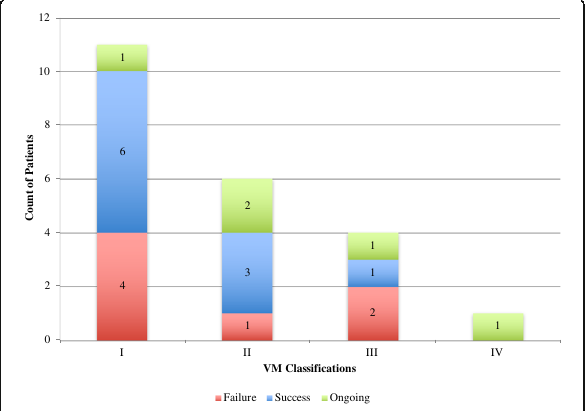
Fig. 1 Success and failures of treatment for each class of